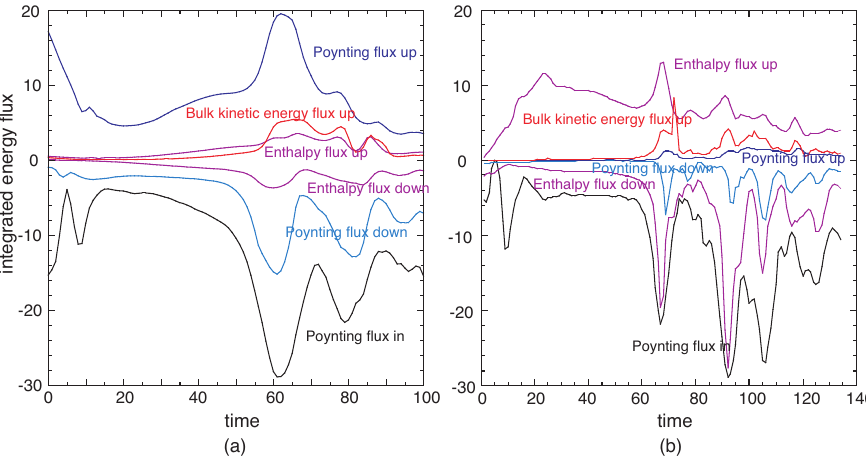
Fig. 5. Temporal evolution of energy fluxes into and out of the reconnection site, integrated over the surfaces of a box shown but the red rectangles in Fig. 4; (a) force-free initial state, (b) shear-free initial state. The solid black lines show the Poynting flux S x into the reconnection site, the blue-colored lines the Poynting flux S z up- and downward from the reconnection site, the green-colored lines the up- and downward enthalpy flux H z , and the red-colored line the upward bulk kinetic energy flux.